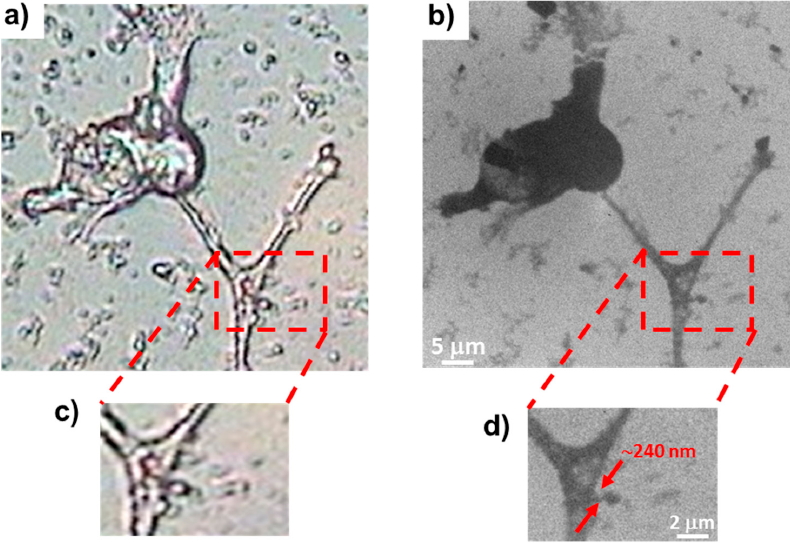
Figure 18. Sample of CT 26 fibroblast cells prepared with a final concentration of 70% EtOH. Comparison of ( a ) optical image and ( b ) SXR image. Insets ( c , d ) show small features imaged (indicated with red arrows in ( d ), of the order of 240 nm) that can be resolved only with the SXR microscope. The dehydration procedure by carbon-rich ethanol washes causes high SXR radiation absorption by the sample. Acquisition parameters: 200 SXR pulses, 20 s exposure. Figure based on [91].